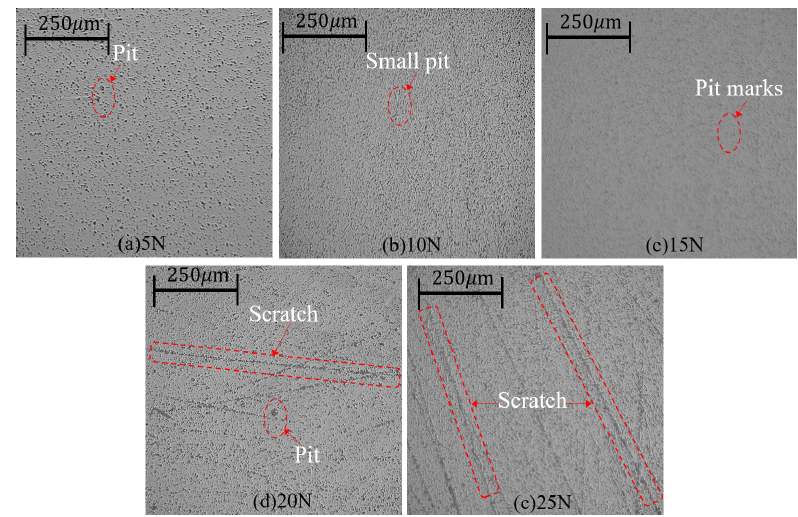
Figure 6. Microscopic appearance of samples under different pressures.